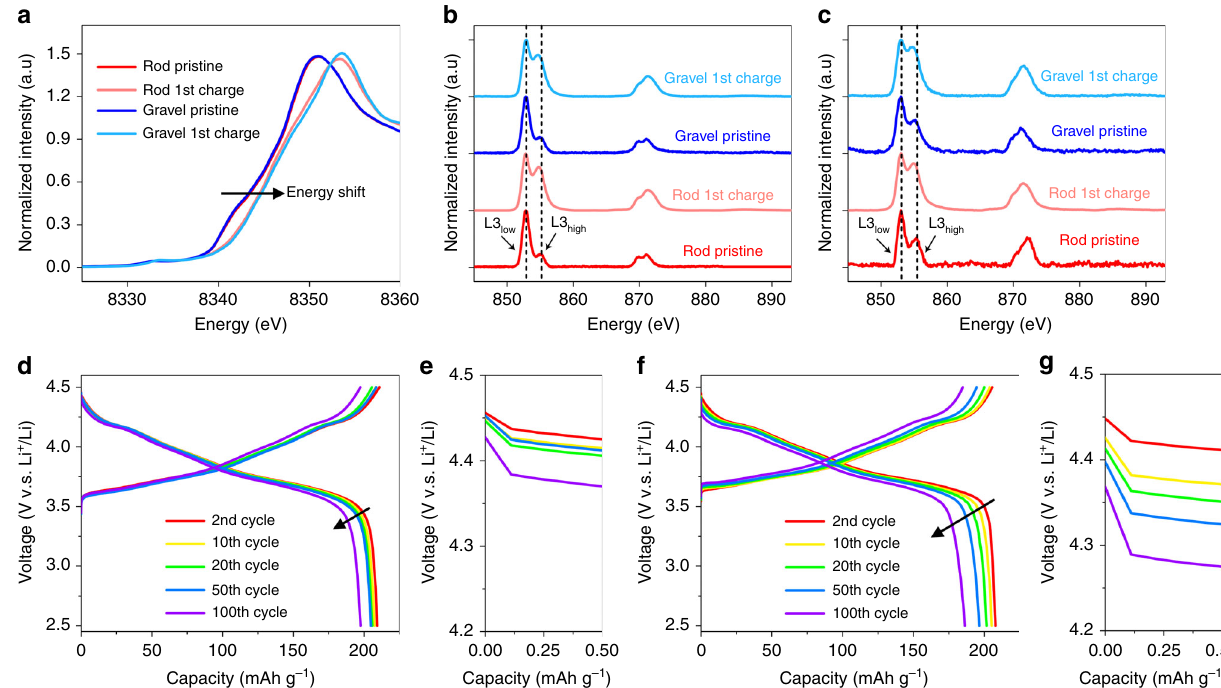
Fig. 2 Electronic structure and electrochemical performance of the rod- and gravel-NMCs. a Ni K-edge XAS, b Ni L-edge XAS (TEY mode), and c Ni L- edge (FY mode) of the rod- and gravel-NMCs in the pristine and the fi rst charged state. d Charge-discharge pro fi le and e voltage drop of rod-NMC at 2.5 – 4.5 V for 100 cycles at C/5 (1C = 200 mA g − 1 ). f Charge-discharge pro fi le and g voltage drop of gravel-NMC at 2.5 – 4.5 V for 100 cycles at C/5 (1C = 200 mA g − 1